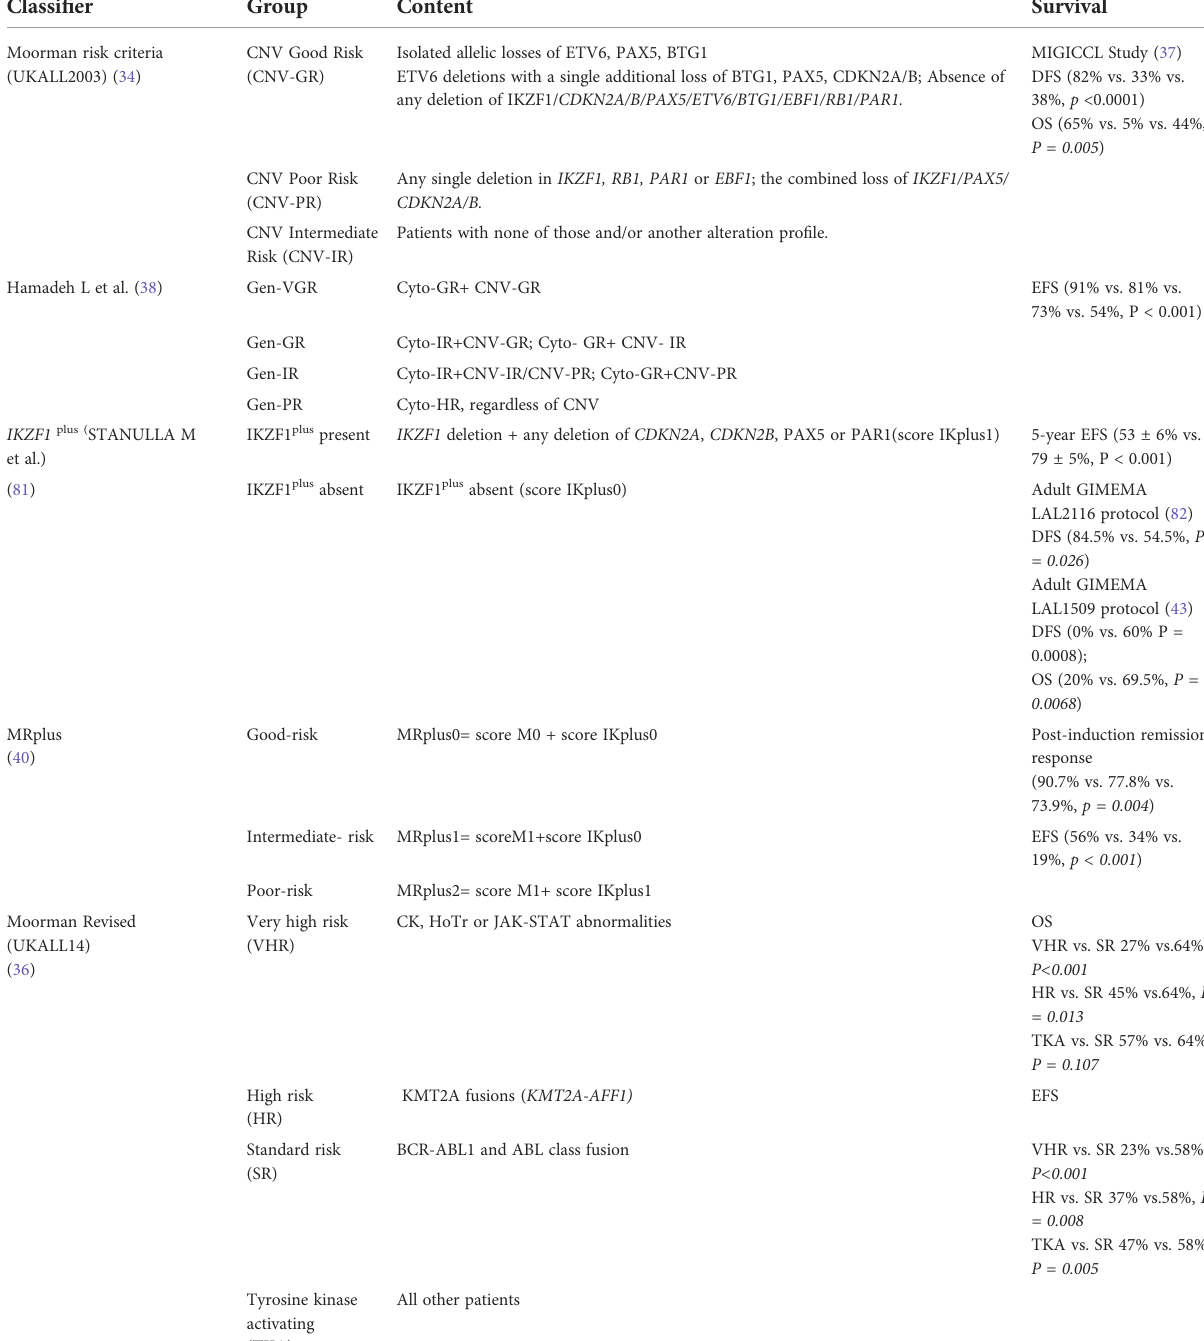
TABLE 2 Current strati fi cation classi fi er of pediatric B-ALL CNV pro fi le. Classi fi